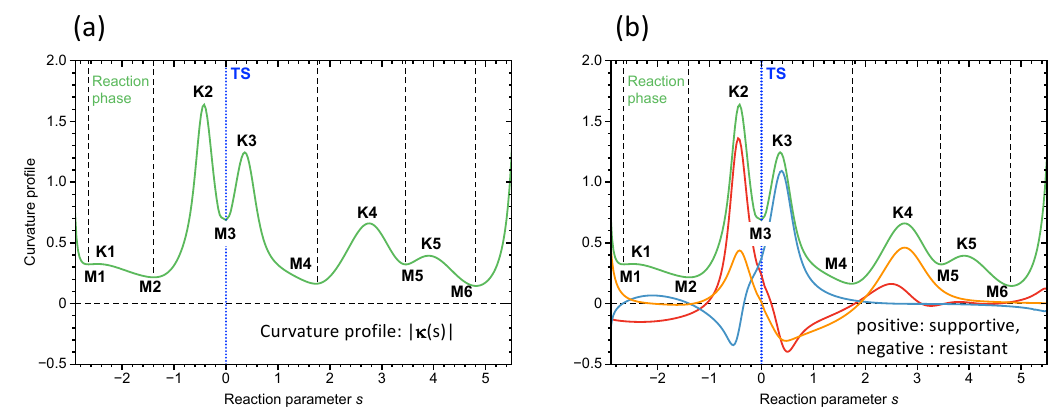
Figure 1. ( a ) Schematic representation of the reaction profile for a model reaction defined as the scalar curvature κ ( s ) (solid green line) given as a function of the reaction parameter s . Curvature minima M and curvature maxima K are shown. The location of the TS is denoted by a dotted blue line. The starts and ends of the reaction phases are denoted by dashed black lines. ( b ) Decomposition of the scalar curvature κ ( s ) into components. Three different components are shown in blue, red, and